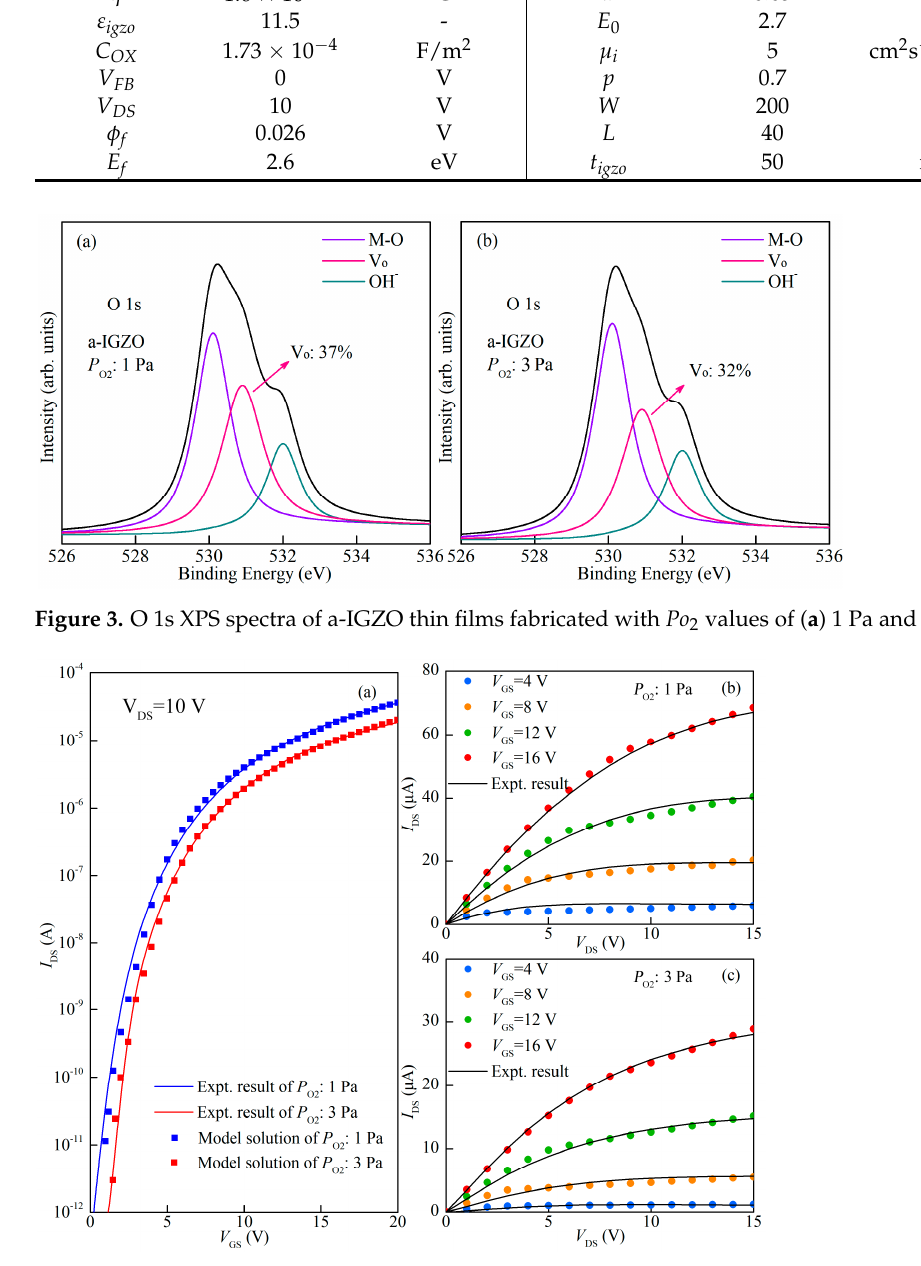
Figure 4. Comparison of ( a ) transfer characteristics and ( b , c ) output characteristics for a-IGZO TFTs fabricated with Po 2 values of 1 Pa and 3 Pa between the model results and experimental data.